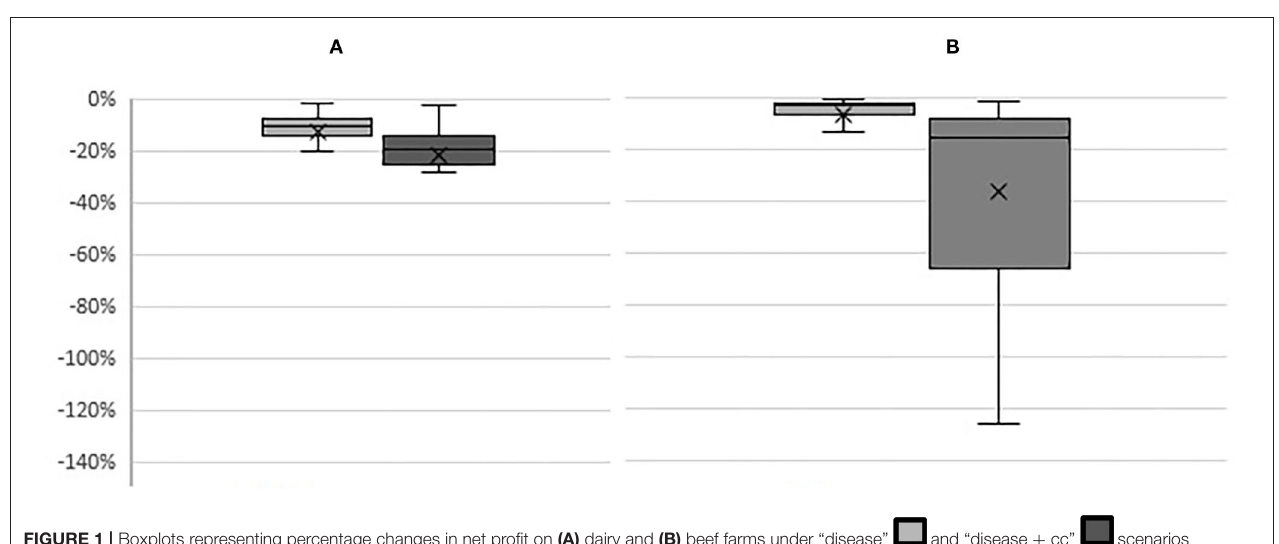
FIGURE 1 | Boxplots representing percentage changes in net profit on (A) dairy and (B) beef farms under “disease” and “disease + cc” scenarios compared to the baseline scenario; (line is the median and cross is the average value for each farm groups; y-axis represents percentage).